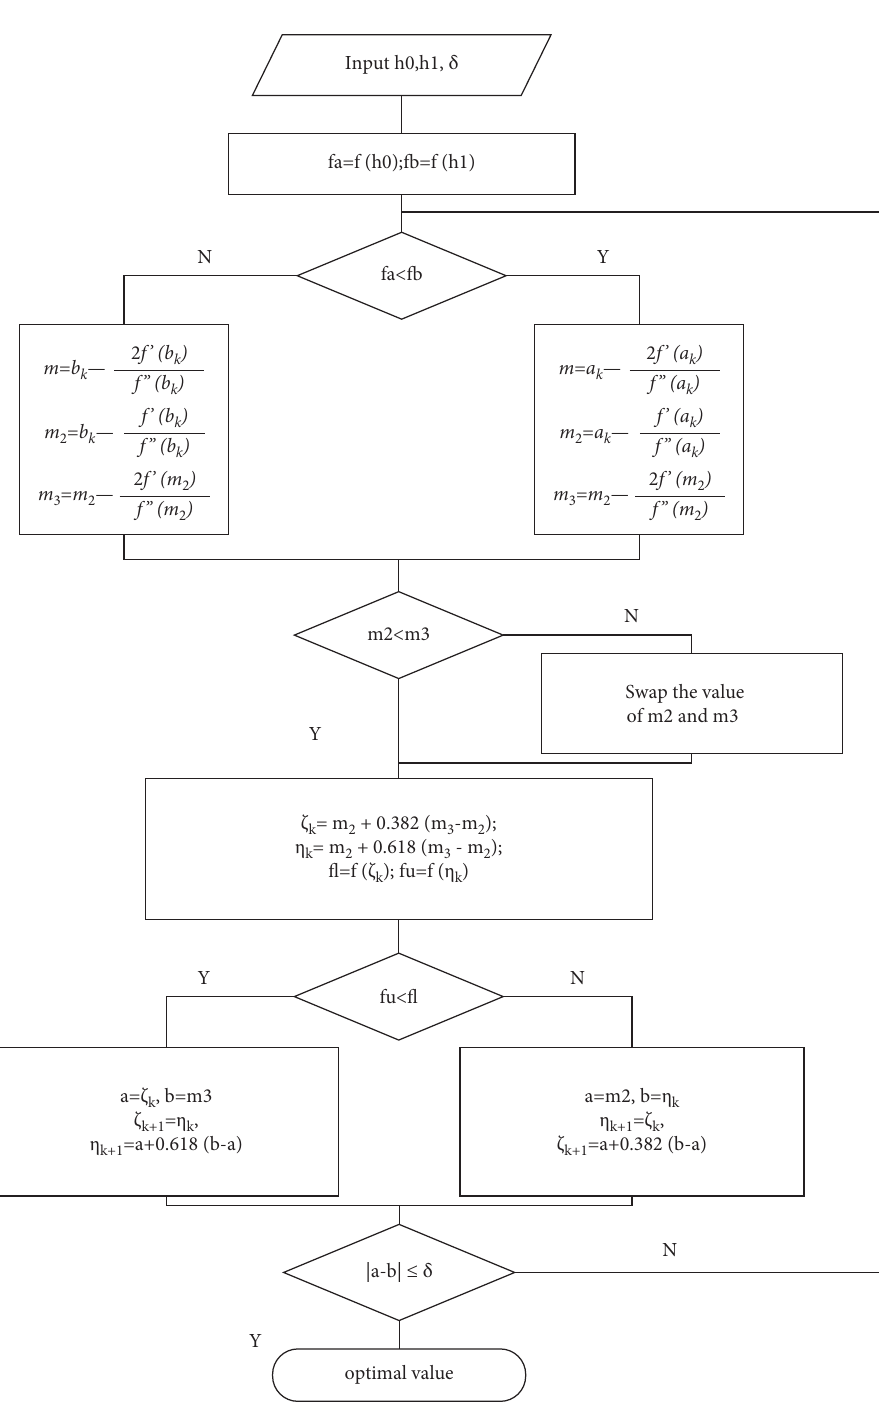
Figure 4: Algorithm program